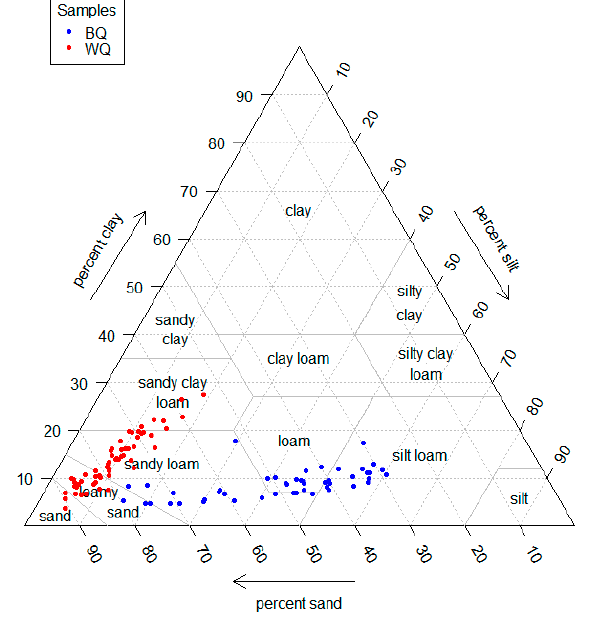
Figure 3. The soil particle size fractions of topsoil observations presented in the United States Department of Agriculture (USDA) texture triangle. Table 2. Descriptive statistics of soil particle size fractions (PSF) of observations.